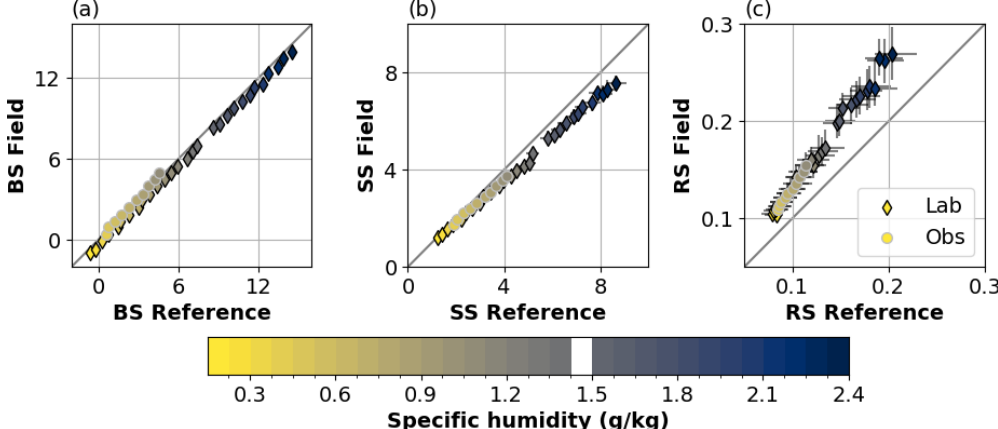
Figure 6. (a) Baseline shift, (b) slope shift, and (c) residuals of the expected model spectrum versus the fitted-absorption spectrum from the analyzer’s WLM for field periods where the warm-box temperature is above the 95th or below the 5th percentiles. Light gray line represents 1-to-1 ratio. Data are divided into 0.075gkg − 1 bins, from 0.15 to 2.4gkg − 1 (color bar), with error bars denoting IQR for both field and reference